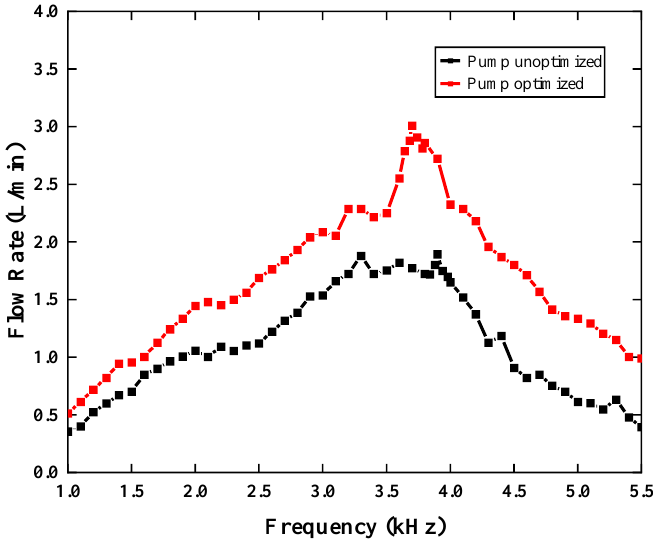
Figure 10. Flowrate curve of unoptimized pump and optimized pump.